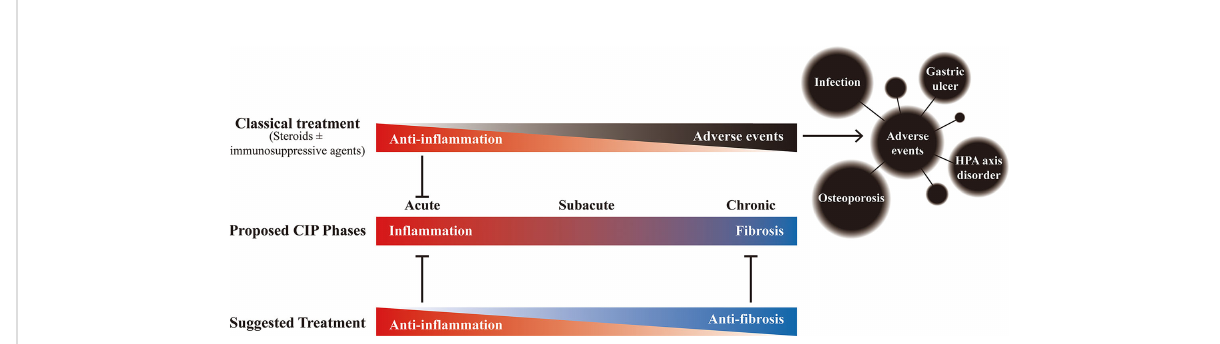
FIGURE 6 The proposed phases of checkpoint inhibitor-related pneumonitis (CIP) and the effects of different treatments. Under the potential development process of CIP, although the classic treatment (steroids ± immunosuppressive agents (such as in fl iximab and mycophenolate mofetil)) can bring anti-in fl ammatory effect in the early stage, long-term use not only fails to bring bene fi ts but also may bring adverse events that affect the overall prognosis. Therefore, it is recommended to gradually transition to anti- fi brotic therapy after adequate anti-in fl ammatory treatment to achieve appropriate management of the whole process of